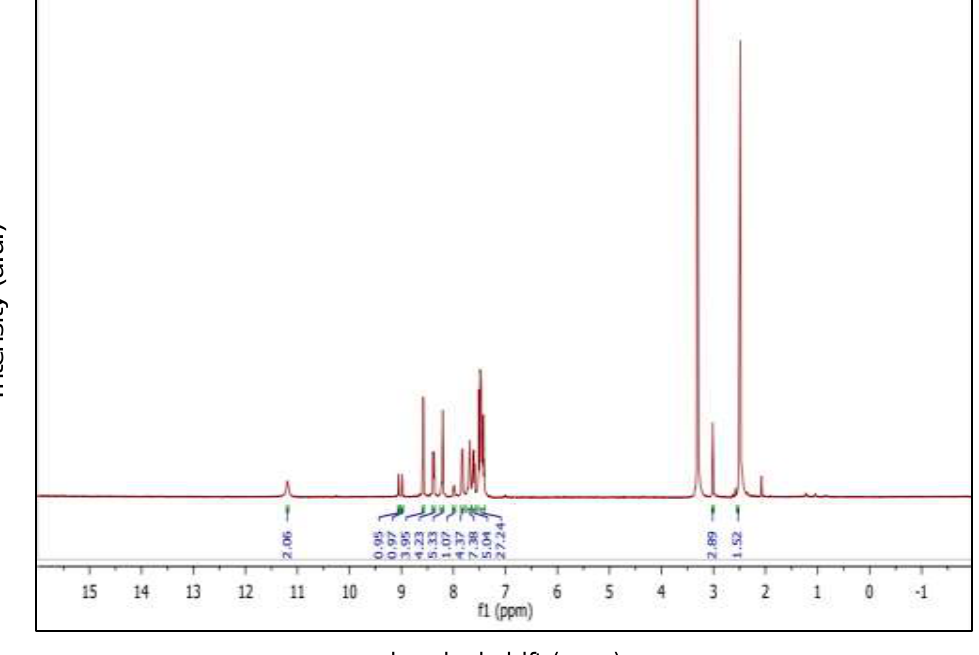
Figure 2: The 1 H-NMR spectrum of